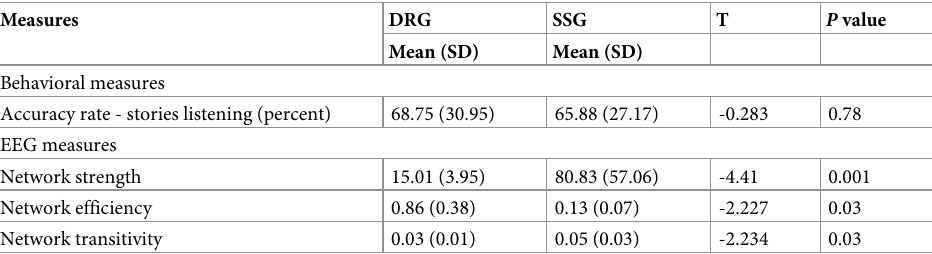
Table 3. Differences in behavioral and network (EEG) measures for the stories-listening task between the dialogic reading and screen stories intervention